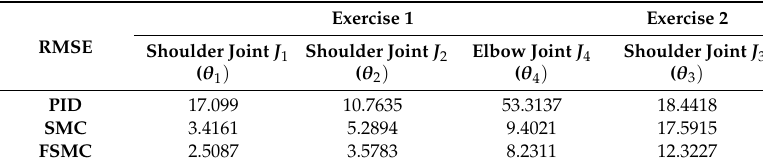
Table 3. RMSE at joints for the PID, SMC, and FSMC.